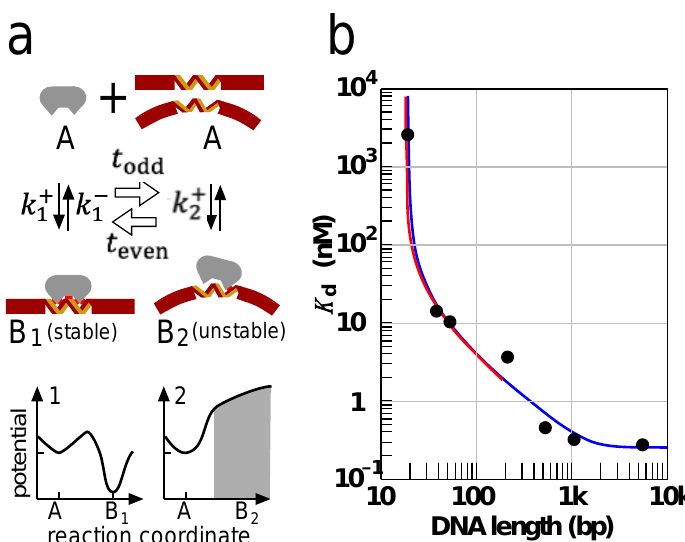
Figure 4. One of the possible molecular models for chemical ratchets in protein–DNA binding. ( a ) Reaction scheme of a chemical ratchet and its alternative Potentials 1 and 2. A DNA binding protein (gray droplets) binds to its specific site (yellow and brown strands) on the DNA (brown bar). The protein stably binds to its specific site on the straight DNA with many cooperative interac- tions (the four small red boxes in B 1 ) in reaction k 1± , and its potential mean force has two local minima. In the presence of one-dimensional diffusion, steps k 1+ and k 1− are both accelerated for longer DNA. In the alternative reaction, A ⇄ B 2 , B 2 has only a weak interaction (a small red box) because of a bend at the specific site and is distributed on the high-energy slope (gray) in the po- tential mean force. Because B 2 is unstable and because the DNA bent inhibits sliding out of the specific site, B 2 is destined to be dissociated without molecular shuffling (making it impossible to define k 2− ). Thus, it cannot be converted into B 1 , and B 1 and B 2 do not coexist. Since switching from B 1 to B 2 rarely occurs due to the enhanced stiffness of the specific site , 𝑡 𝑜𝑑𝑑 is larger than the time- scale of the binding, making the timescale of the switching slower (larger), even though 𝑡 𝑒𝑣𝑒𝑛 may be small. ( b ) The antenna effect of TrpR binding to trpO . The values of the dissociation con- stant (closed circles) were obtained with the site-specific hydroxyl radical footprinting of TrpR on trpO DNA of various lengths. The differential equations composed of rate equations and diffusion equations corresponding to the one-dimensional diffusion of TrpR along the DNA were solved in a stationary state to provide the best-fit curve (blue line) with a site size of 18 bp and a diffusion distance of 625 bp (blue) [16]. Another theoretical calculation of chemical ratchet under the as- sumption of rapid diffusion for short DNA gave the best-fit curve with a site size of 18 bp (red curve) [21], where Panel b is taken from.